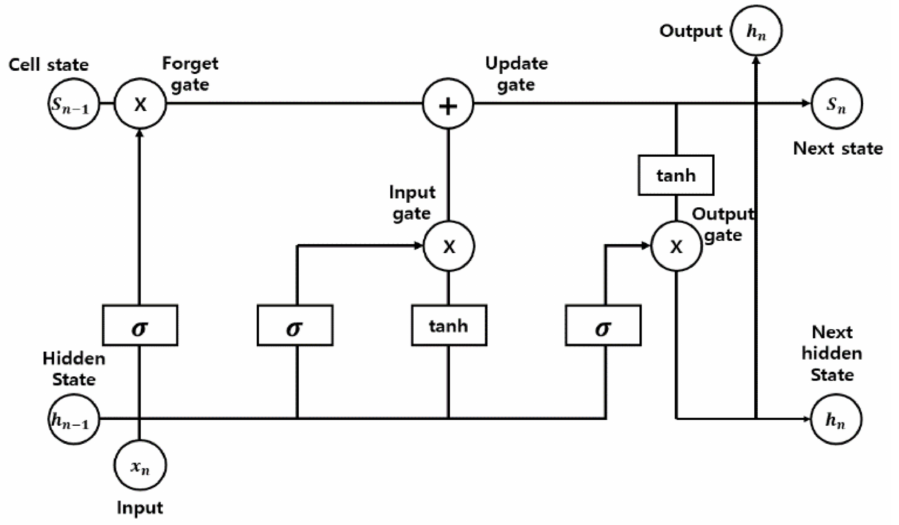
Figure 5. Structure of an